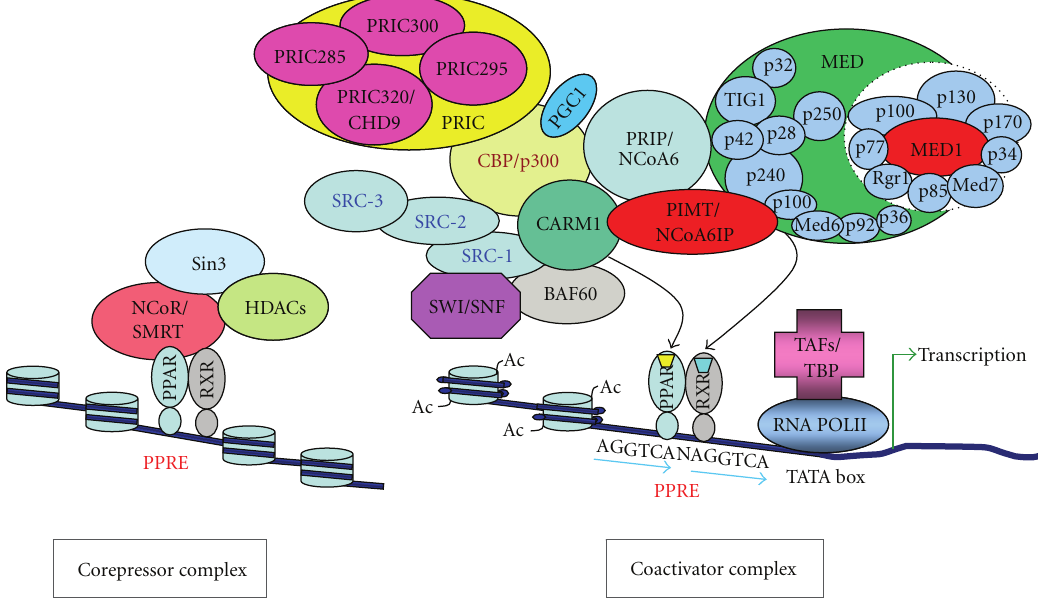
Figure 1: A schematic representation of ligand-dependent recruitment of coactivators for PPAR-regulated target gene transcription. In the absence of ligand, the PPAR-RXR heterodimer recruits corepressors, which in turn, assemble additional components of a repressor complex including histone deacetylase (HDAC). When ligand (yellow trapezium representing PPAR ligand, and blue trapezium representing 9-cis- retinoic acid as RXR ligand) binds, conformational changes in PPAR-RXR induce dissociation of corepressor complex. Active transcriptional complex assembles with coactivator proteins either sequentially or preassembled subcomplex modules. PPAR binds to peroxisome proliferator response element (PPRE) and assemble coactivator complexes that acetylate (SRCs, p300) or methylate (CARM1) nucleosomes for chromatin remodeling. Mediator components [36, 37] contact PPARs and facilitate the recruitment of the basal transcription machinery (TATA-box-binding protein [TBP]/TBP-associated factors [TAFs]) to form linkage with RNA polymerase II for transcription of specific target genes.